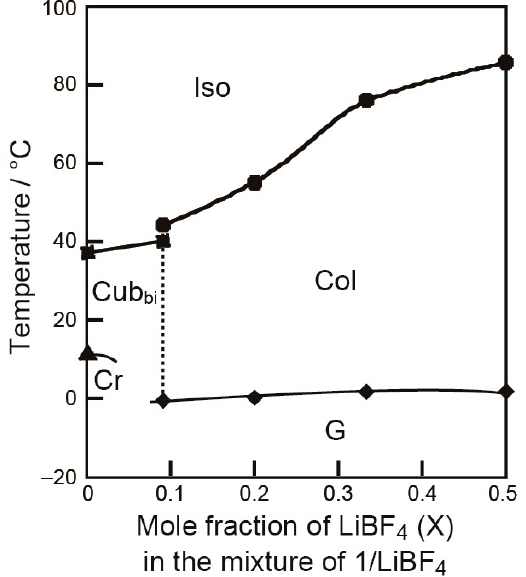
Figure 5. Phase diagram of the 1 /LiBF 4 mixtures as a function of the mole fraction of LiBF 4 (X) in the mixtures. Cr, crystalline; Col, columnar; Cub bi , bicontinuous cubic; Iso, isotropic.